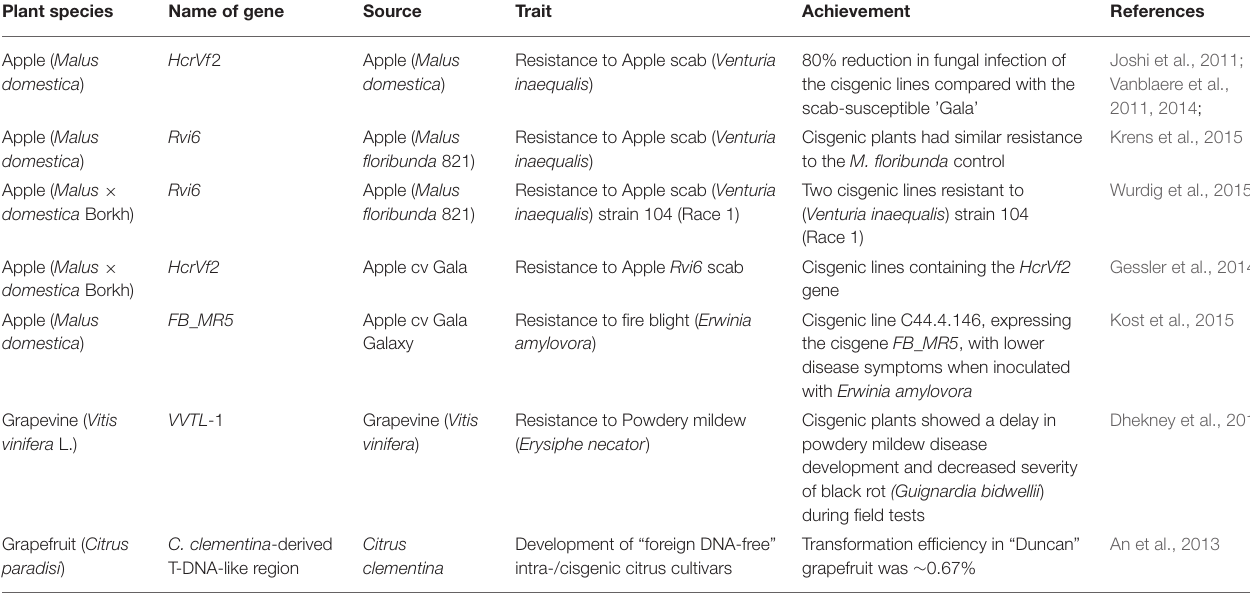
TABLE 1 | Applications of cisgenesis and intragenesis in woody fruit